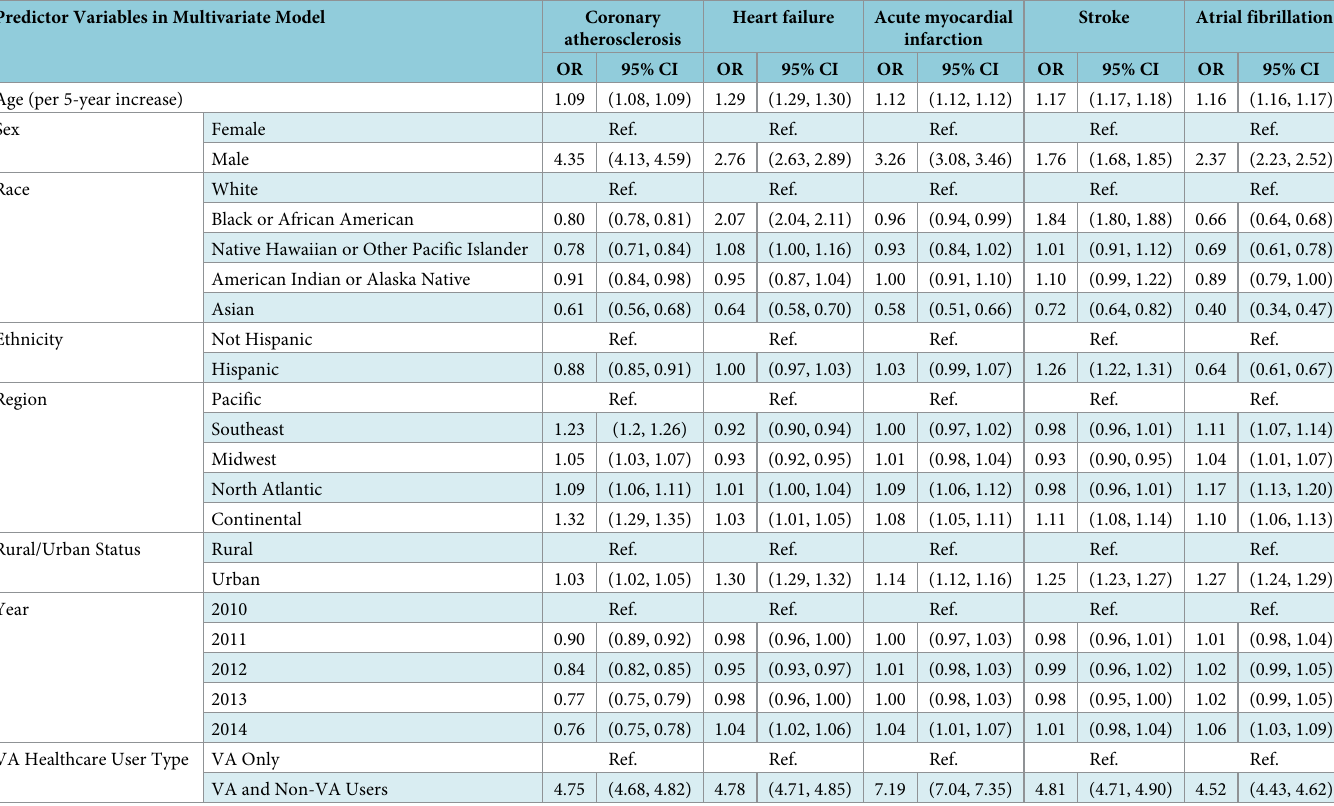
Table 4. Five multivariable model evaluating predictors of hospitalization due to each of the top 5 cardiovascular conditions §. Predictor Variables in Multivariate